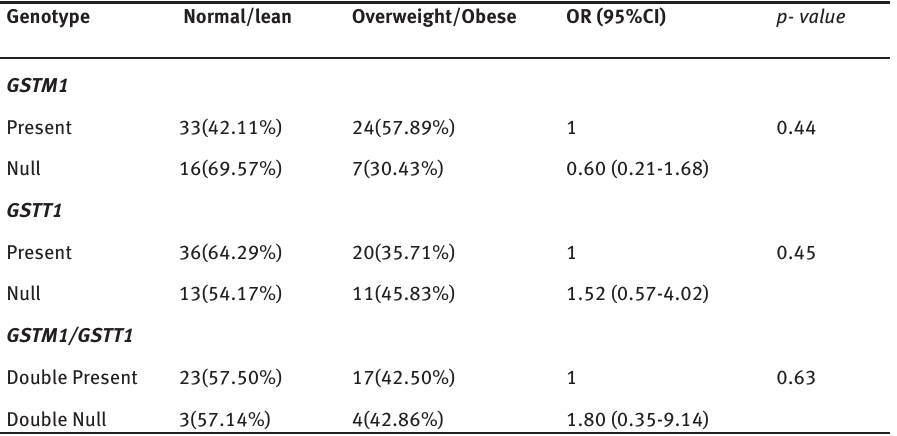
Table 4 : Association of GSTM1 and GSTT1 genotypes with the body mass index (BMI) in breast cancer patients.